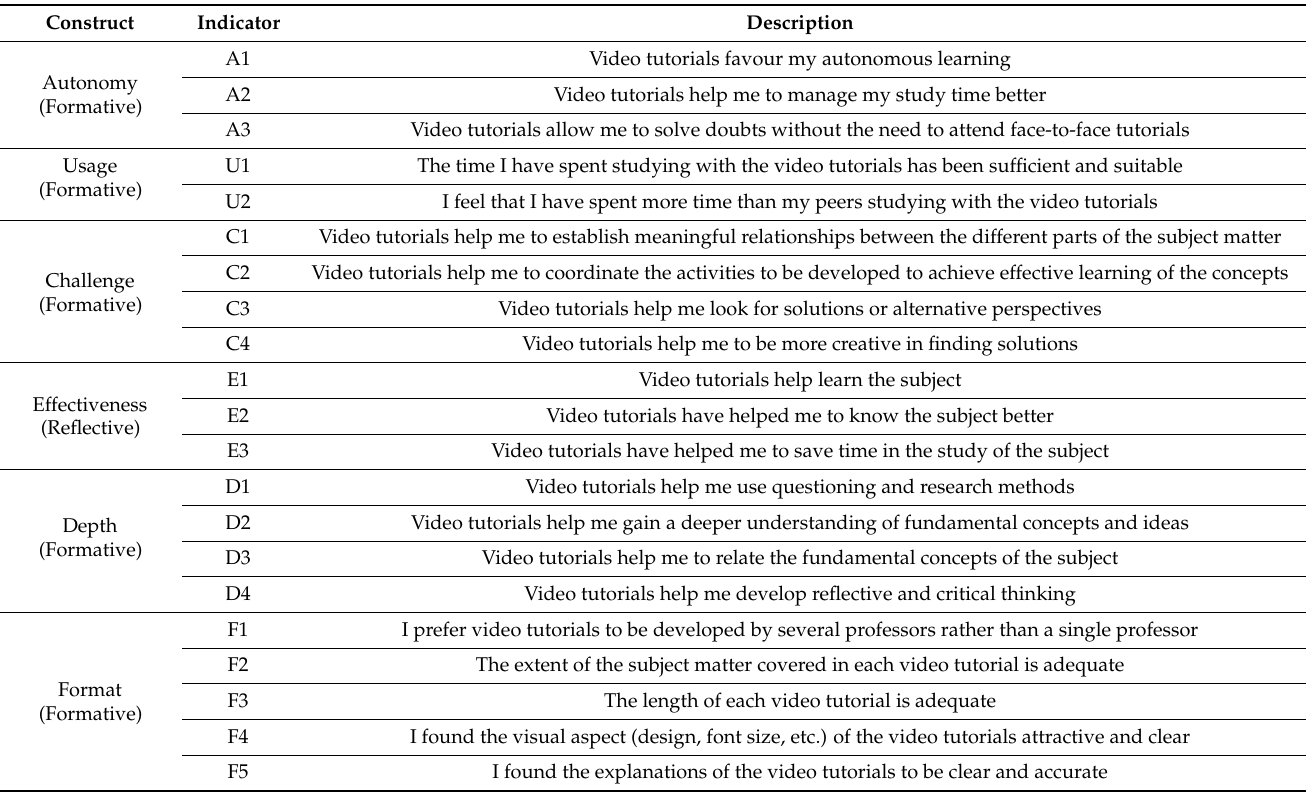
Table 1. Constructs and indicators.